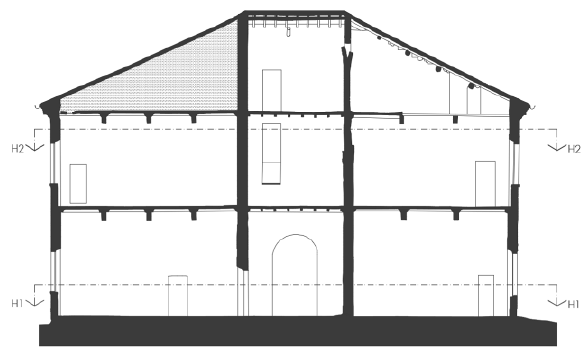
Figure 5: Vertical section V2 obtained from the points cloud (Municipality of Mantua).